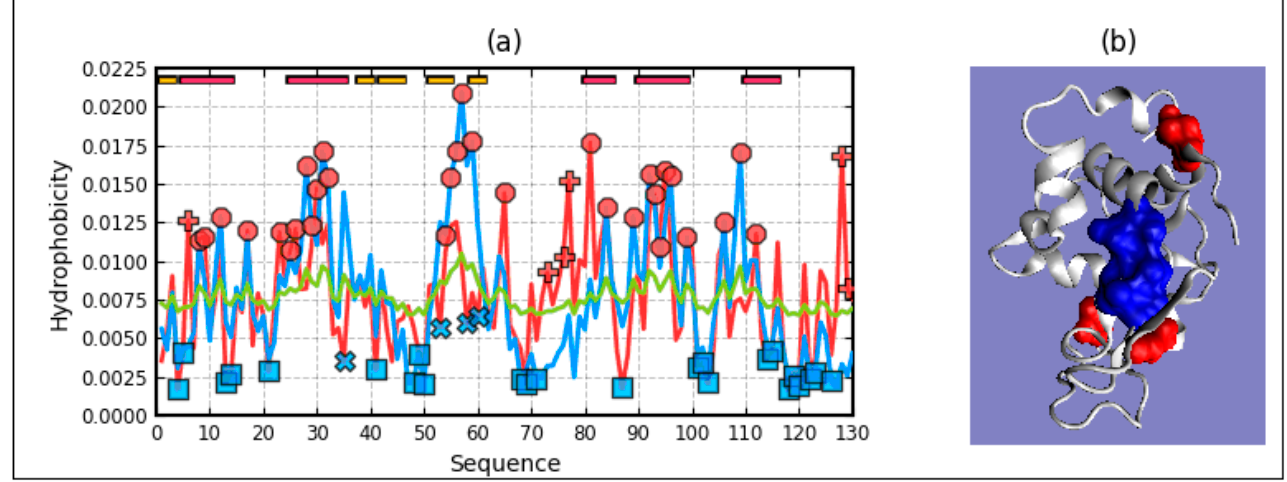
Figure 16. Profiles in human lysozyme. ( a ) T—blue, O—red, and M—green profiles. The blue squares—residues on the surface representing low hydrophobicity—status accordant with FOD criteria. ( b )—3D structure of lysozyme. The residues with hydrophobicity excess ((“+” on the profiles in ( a ))—red, residues with local hydrophobicity deficiency (“X” on the profiles in ( a ))—blue.